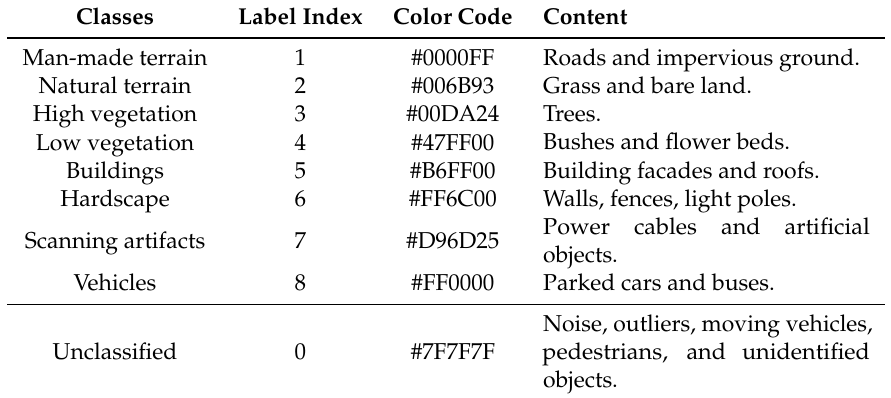
Table 2. Annotated classes of